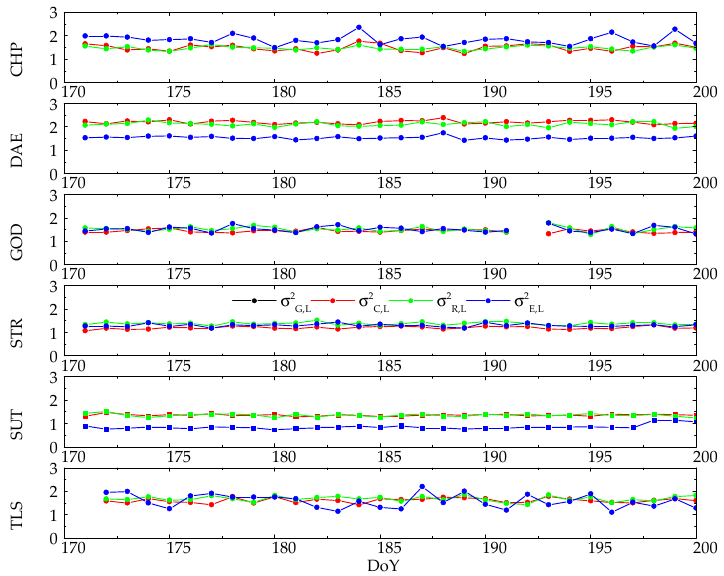
Figure 4. Daily average variance of unit weight of Multi-GNSS phase observations in different baseline tests.